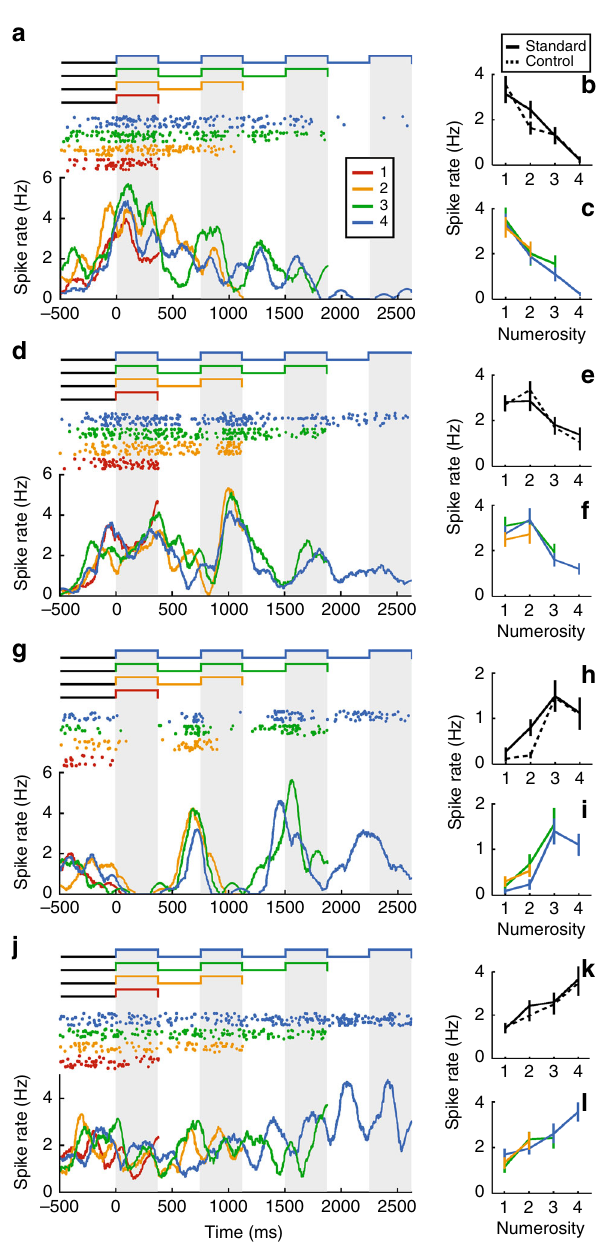
Fig. 2 Neuronal responses to numerosity during the sample period. a – l Single-neuron responses during sample presentation to the sequential presentation format. The three depicted example neurons preferred numerosities 1 ( a ), 2 ( d ), 3 ( g ), and 4 ( f ). Big panels: neuronal activity over the course of sample presentation during sequential control 2 trials. Top: dot-raster histogram, where dots represent action potentials and one row = one trial. Background shading indicates item present. Sample presentation started at time point 0 ms. Bottom: Averaged spike density function. b , e , h , k Average activity of the respective neurons during standard and control trials. c , f , i , l Average activity split by fi nal item count. All error bars indicate ± SEM.